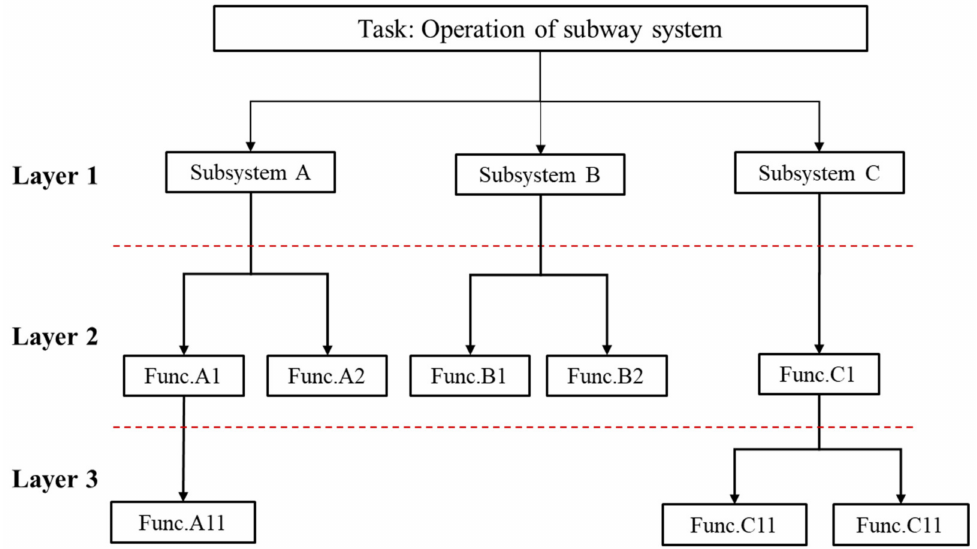
Figure 2. An example of the functional decomposition of a subway